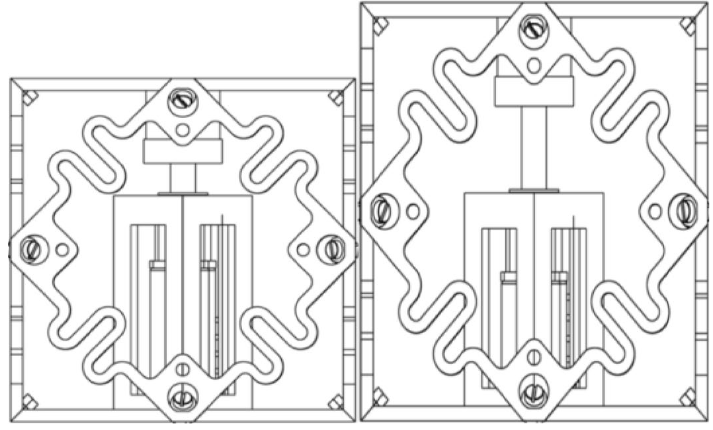
Figure 15. Schematic diagram of the active cell with different excitement signal.